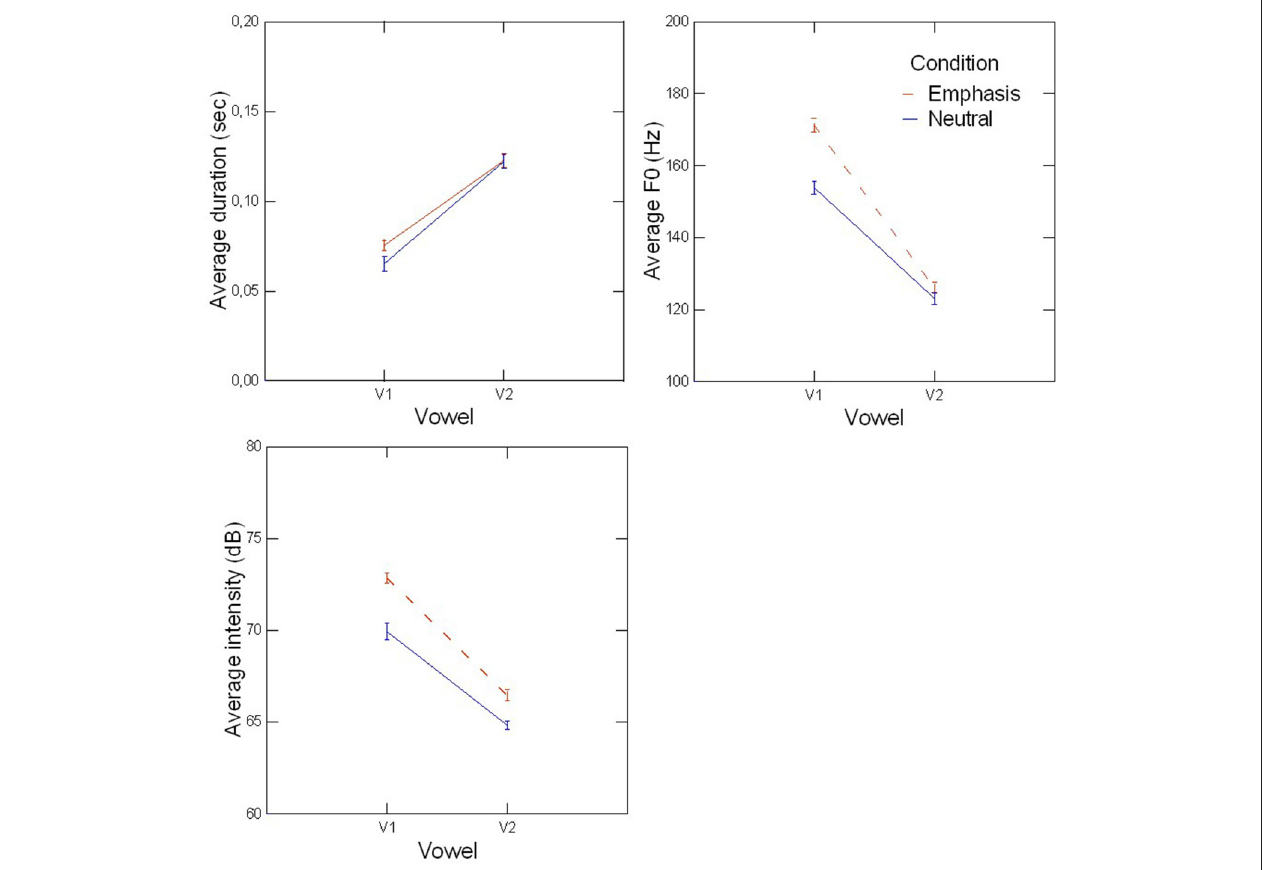
FIGURE 1 | Average duration (Upper Left) , F0 (Upper Right) , and instensity (Lower Left) measured on the first (V1) and second (V2) vowels of the disyllabic target word, for each prosodic condition (neutral and emphasis). Error bars are standard